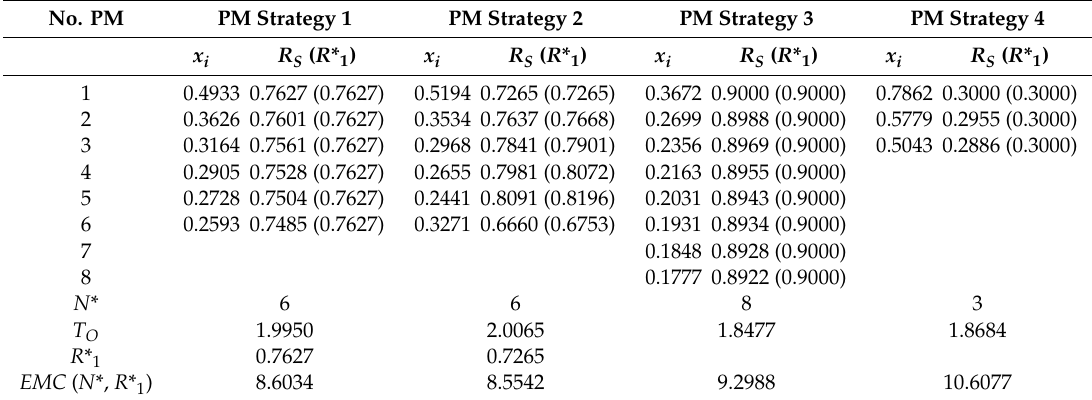
Table 5. The optimal solutions and their system